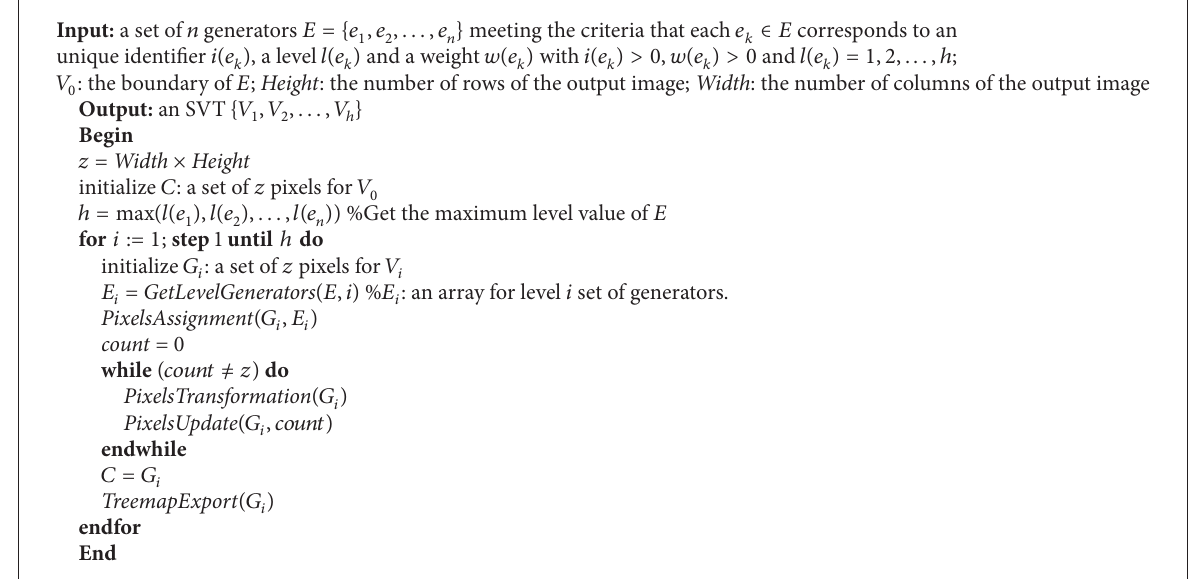
Algorithm 1: SVT